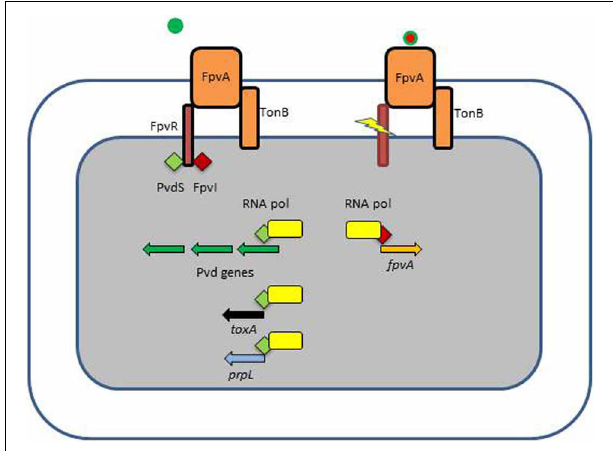
Frontiers in Cellular and Infection Microbiology